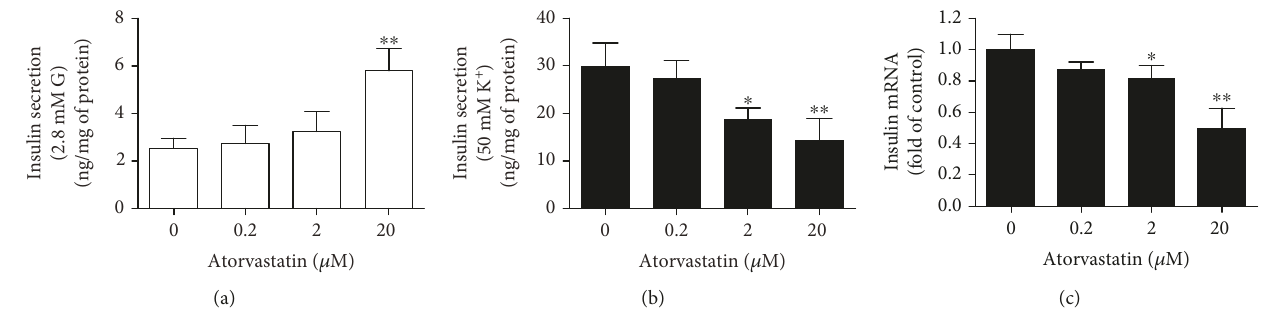
Figure 1: E ff ect of atorvastatin on basal insulin secretion and potassium-stimulated insulin secretion in INS-1 cells. (a) 20 μ M atorvastatin increased basal insulin secretion. (b) 2 μ M and 20 μ M atorvastatin signi fi cantly reduced the potassium-stimulated insulin secretion after 24h of incubation. (c) qRT-PCR assay analysis of insulin expression in INS-1 cells treated with di ff erent concentrations of atorvastatin for 24h. Values presented are the means ± standard deviations of three independent experiments. ∗∗ P < 0 05 and ∗ P < 0 01 compared to 0 μ M atorvastatin